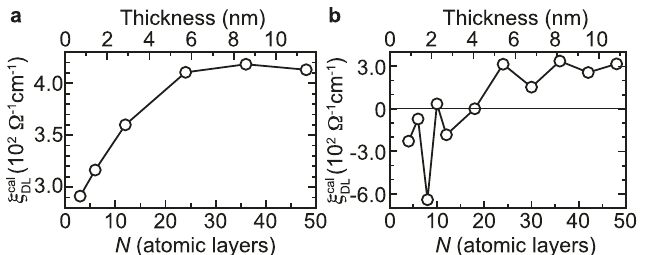
for ( a ) Ni(12)/Ti( N ) and ( b ) Ni(12)/ DL